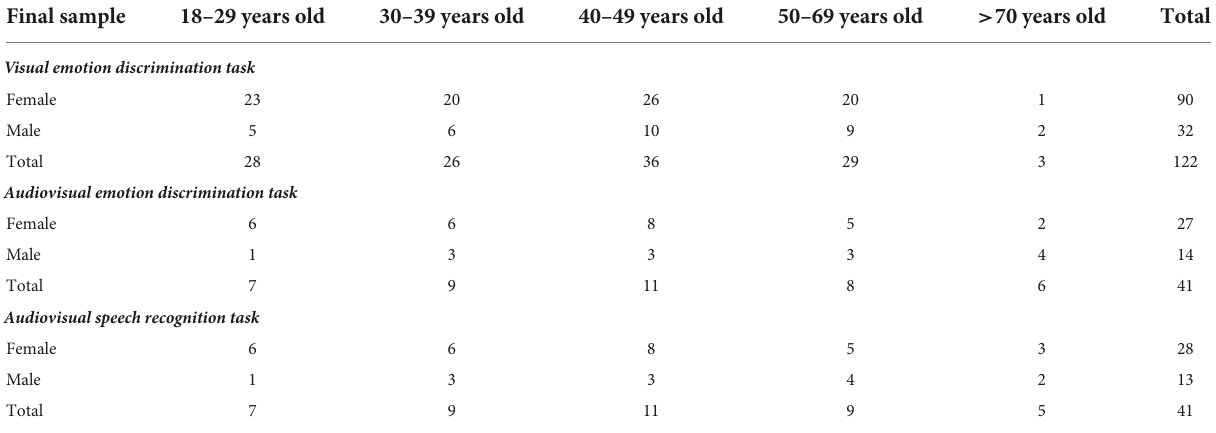
TABLE 1 Repartition of participants according to age and gender in the three tasks. Final sample